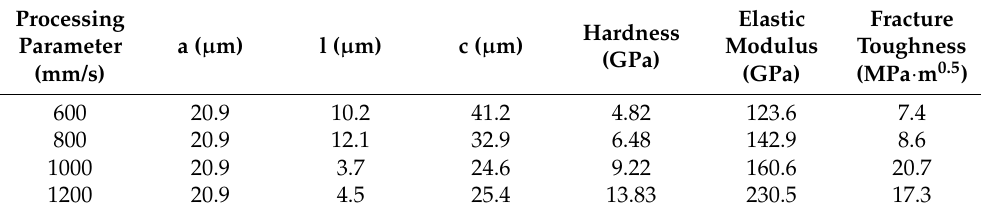
Figure 6. BSE-SEM micrographs of Nb-18Si-5HfC alloy scanning speed for 1000 mm/s showing microcrack deflection due to the impartation of extrinsic toughening by an HfC particle. Table 1. Fracture toughness calculated at different scanning speeds.